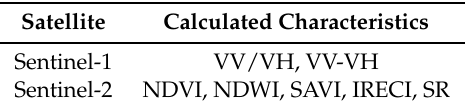
Table 1. Calculated characteristics for each one of the satellites.